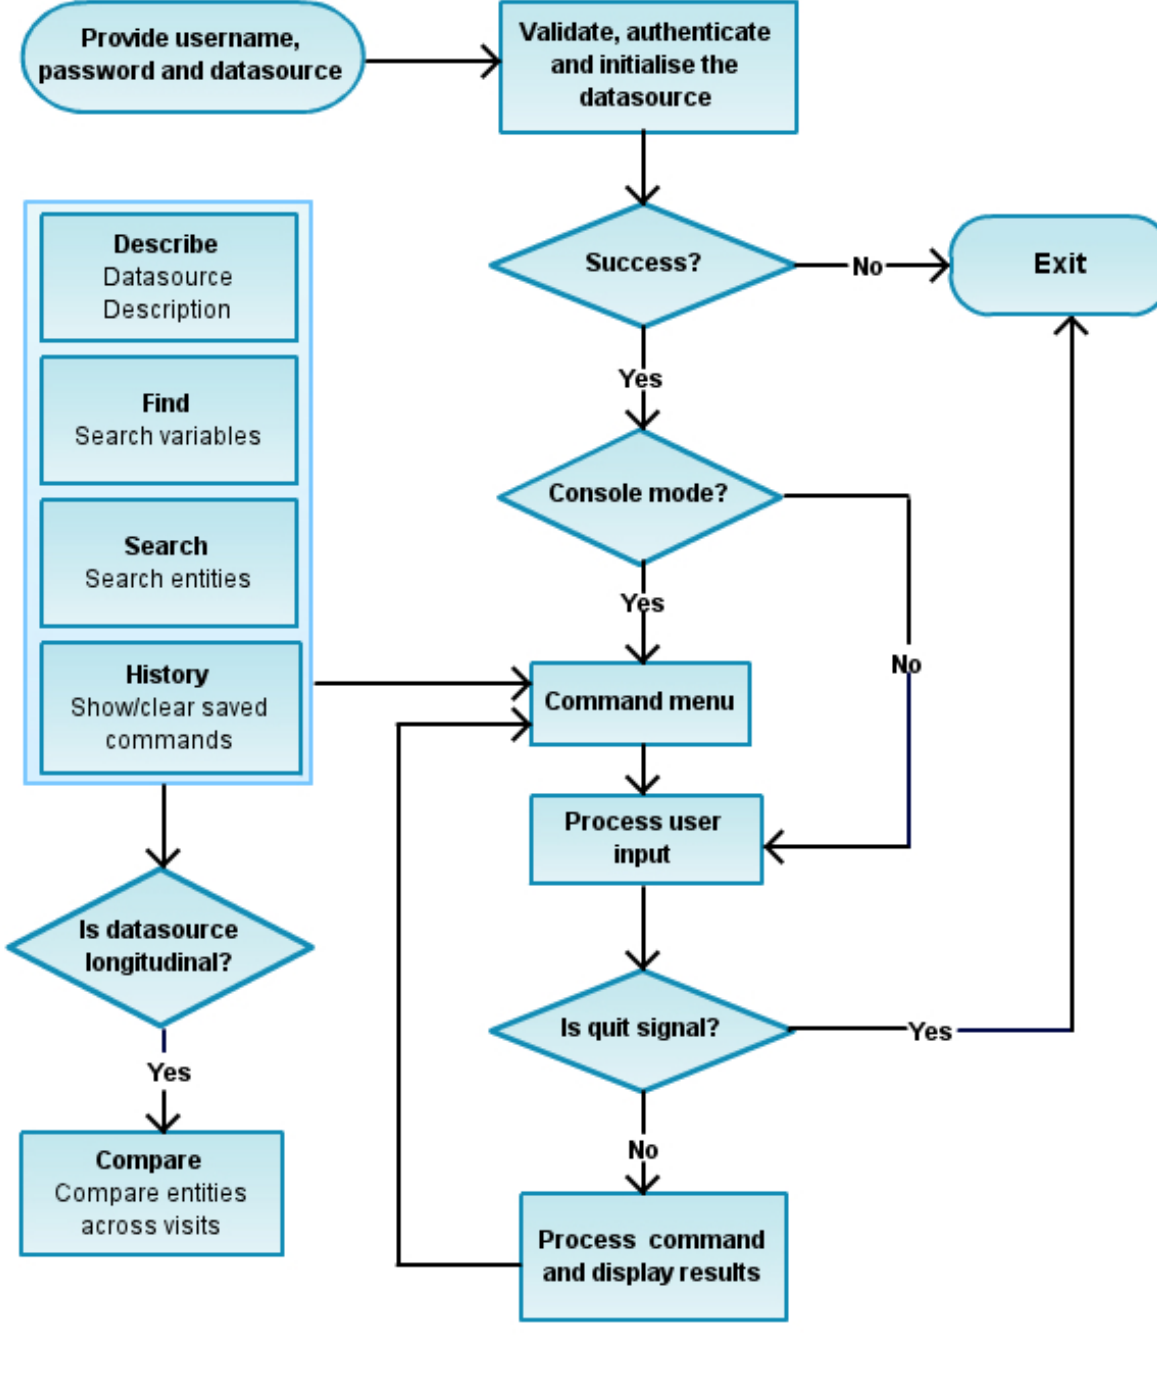
Figure 3. The flow chart showing the overall work flow of CohortExplorer. The user runs CohortExplorer by providing the datasource name, username, password and the command to execute. When running the application in console/interactive mode (determined by the console command) a menu of available commands is displayed. The user inputs the command along with command options and arguments (if applicable), the application processes the command and displays the results. When running the application on standard Linux shell the application simply processes the command input, displays the results and terminates the